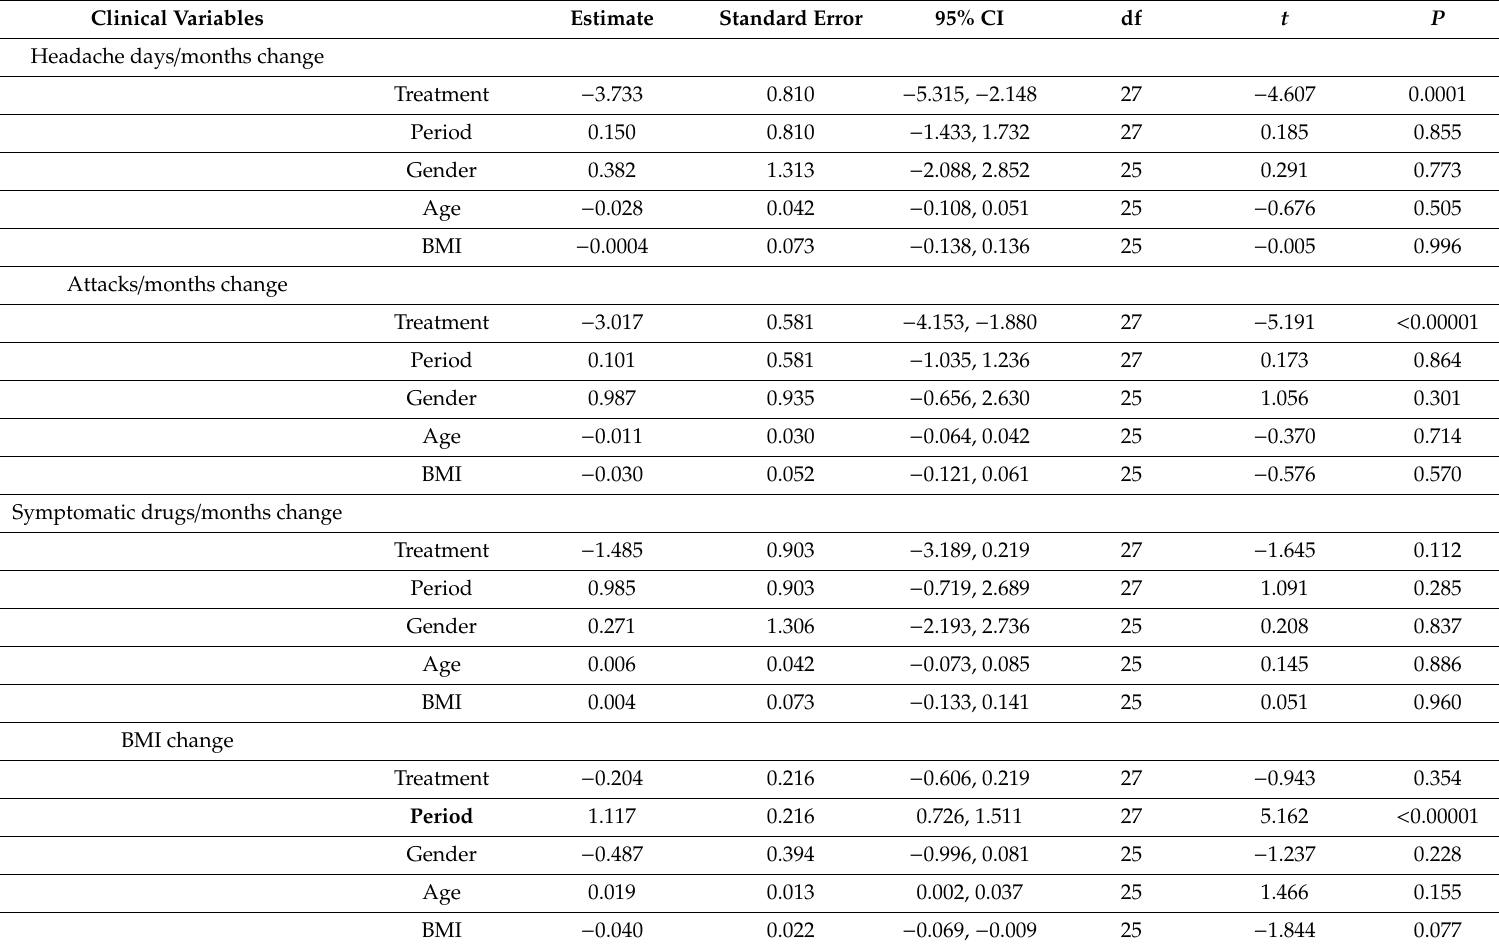
Table 3. Results of linear mixed-e ff ect